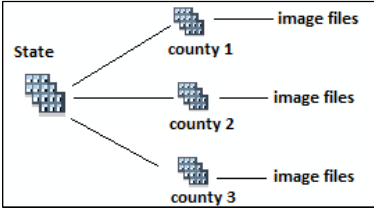
Figure 12. Cascaded mosaic